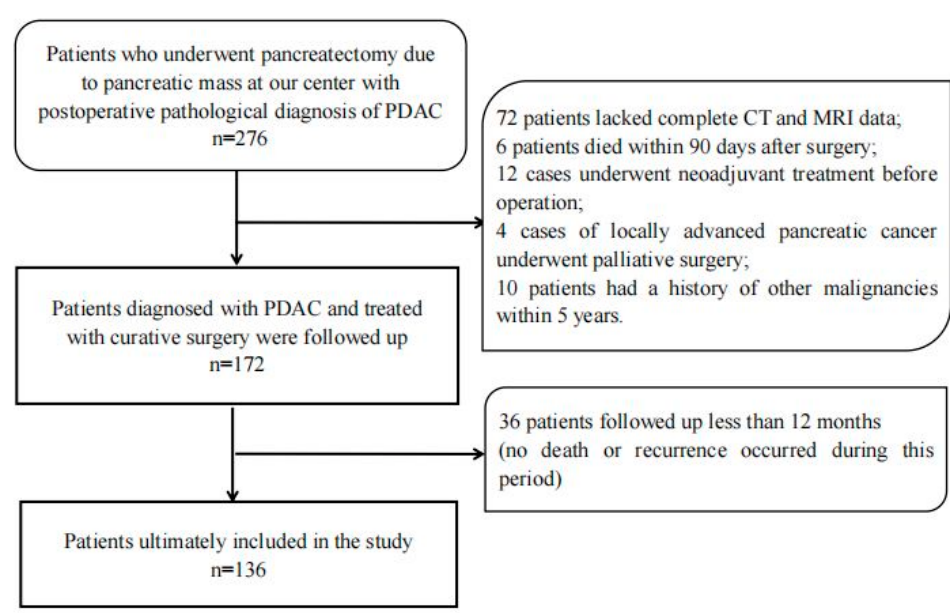
Figure 1. Description of study methods and demographic data.